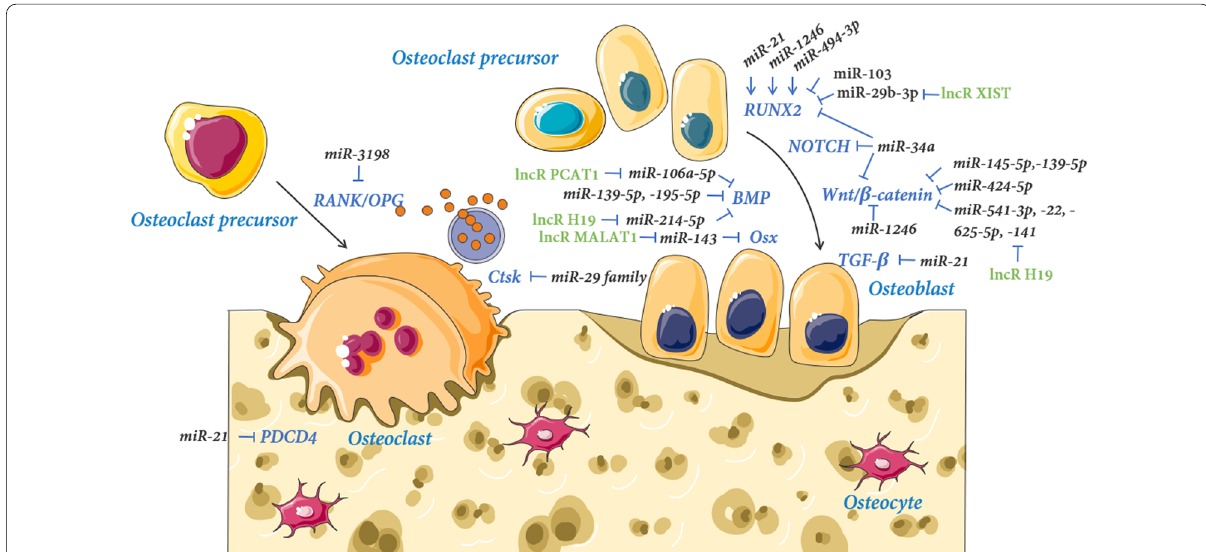
Fig. 6 Mechano-sensitive ncRNAs in bone remodeling. The microRNAs and lncRNAs are regulated by various mechanical forces via altering gene targets. Obviously, the current research focuses on osteoblastic cell lines, and the mechano-sensitive RNA of osteoclast cell lines needs further